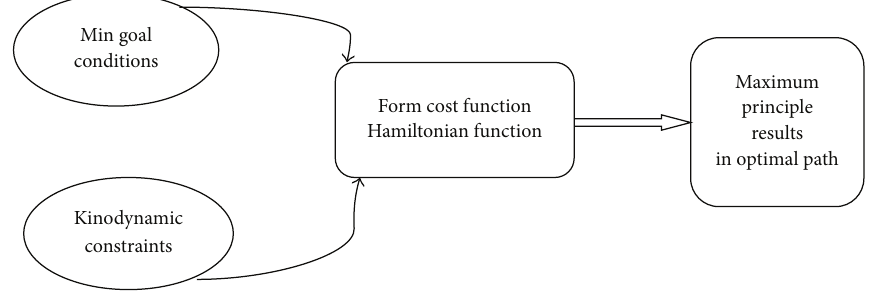
Figure 11: Basic optimization problem